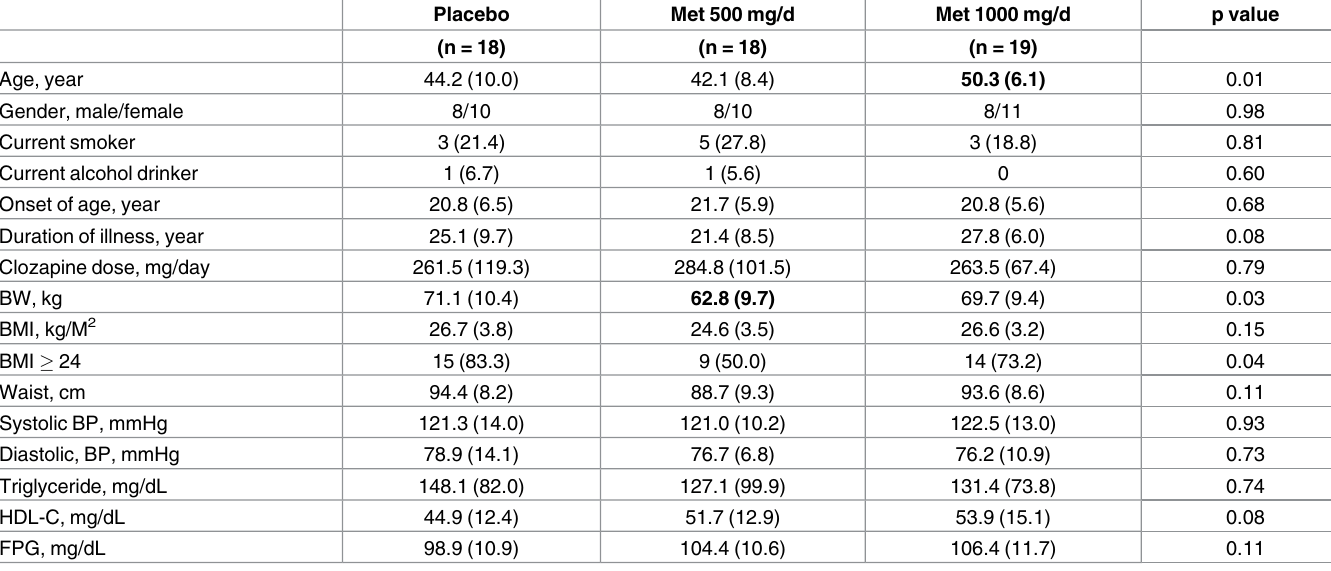
Table 2. Baseline characteristics of patients in placebo, metformin at 500 mg/d, and metformin at 1000 mg/d